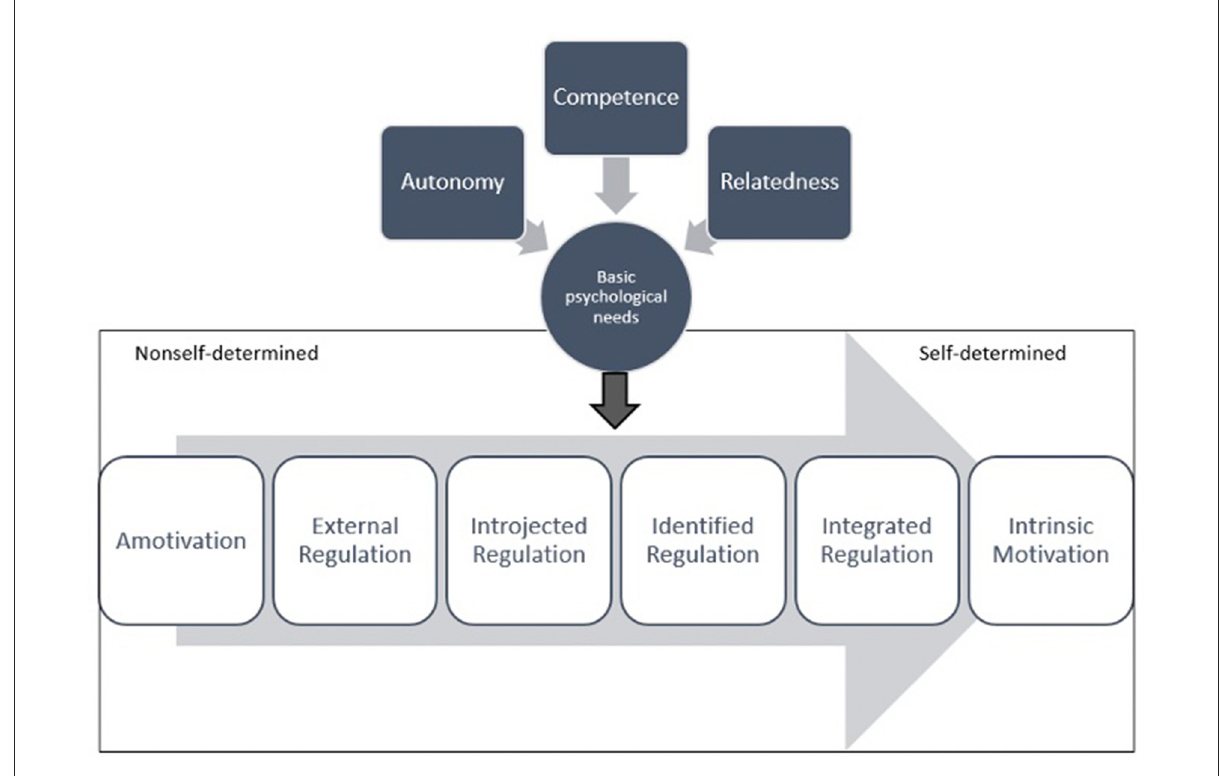
FIGURE1 Self-determination theory psychological needs and the motivation